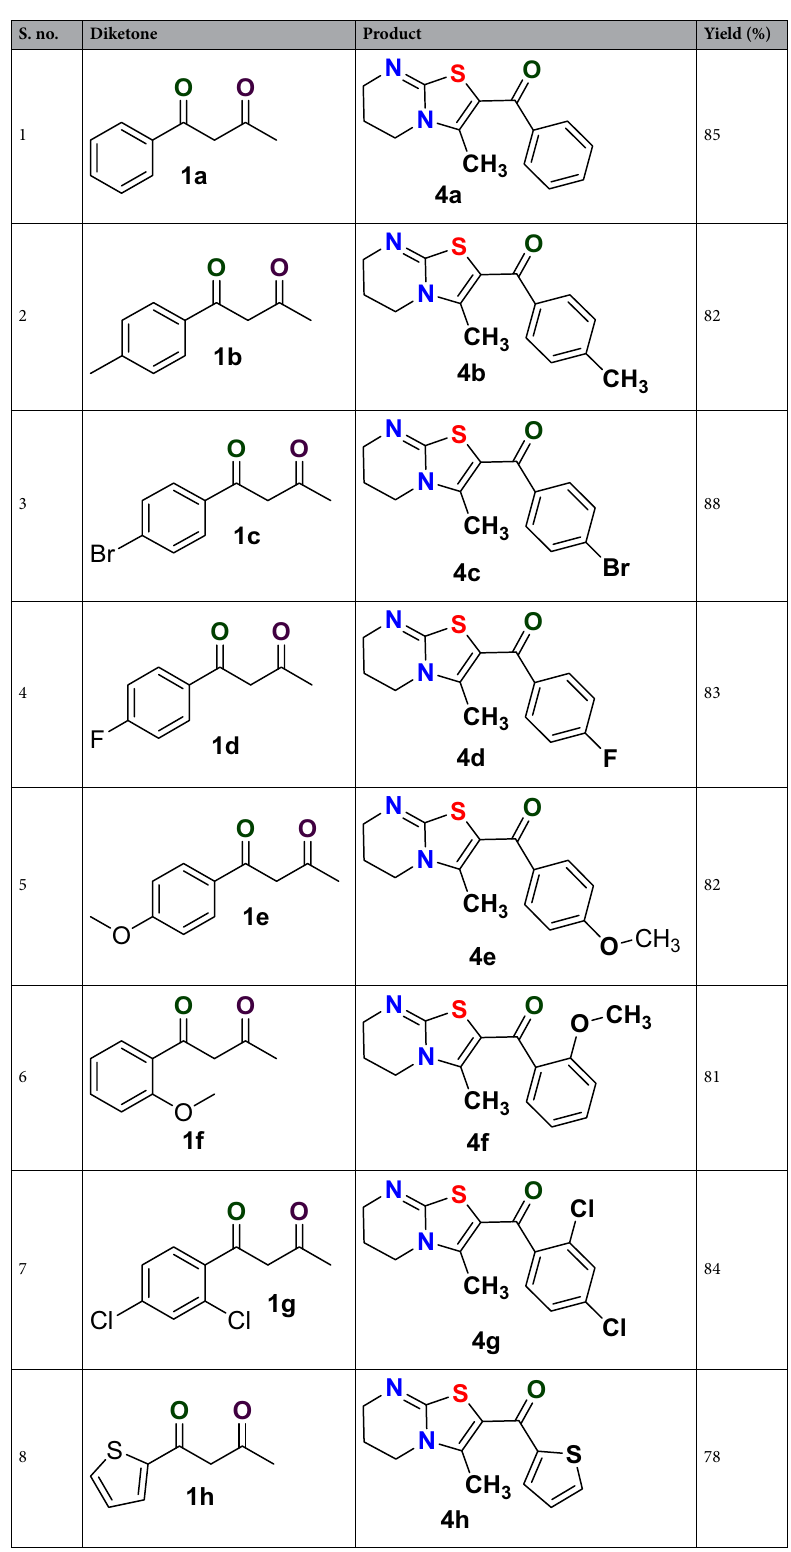
Table 1. Showing the product formation along with the reaction